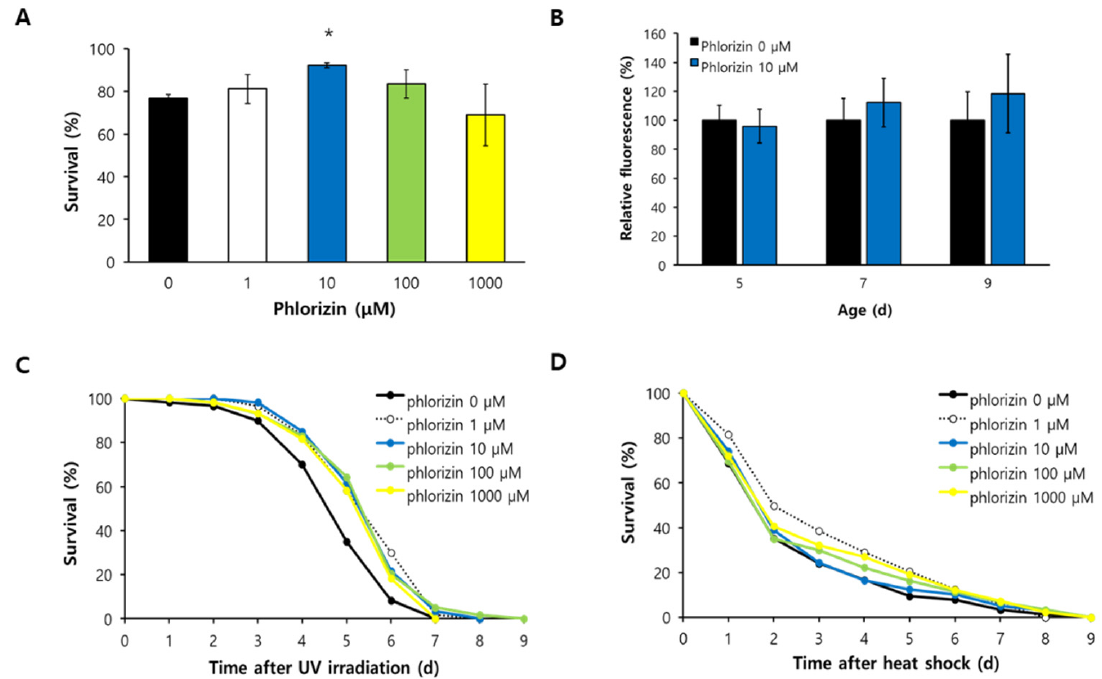
Figure 1. Effects of phlorizin on stress response and cellular ROS levels. ( A ) Resistance to oxidative stress induced by H 2 O 2 was examined. ( B ) Cellular ROS levels were compared between untreated control and worms treated with 10 µ M of phlorizin in 5-, 7-, and 9-day-old worms. Survival after UV irradiation ( C ) or heat shock ( D ) was examined with different concentrations of phlorizin; 0, 1, 10, 100, and 1000 µ M. Error bar indicates standard error. *, a significant difference ( p < 0.05) compared to untreated control (0 µ M of phlorizin).